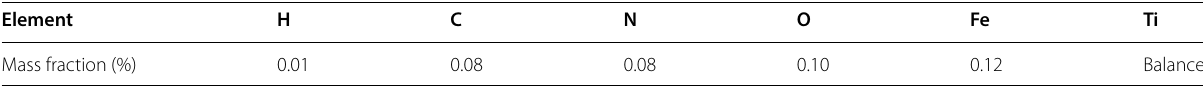
Table 1 Compositions of TA2 titanium foils